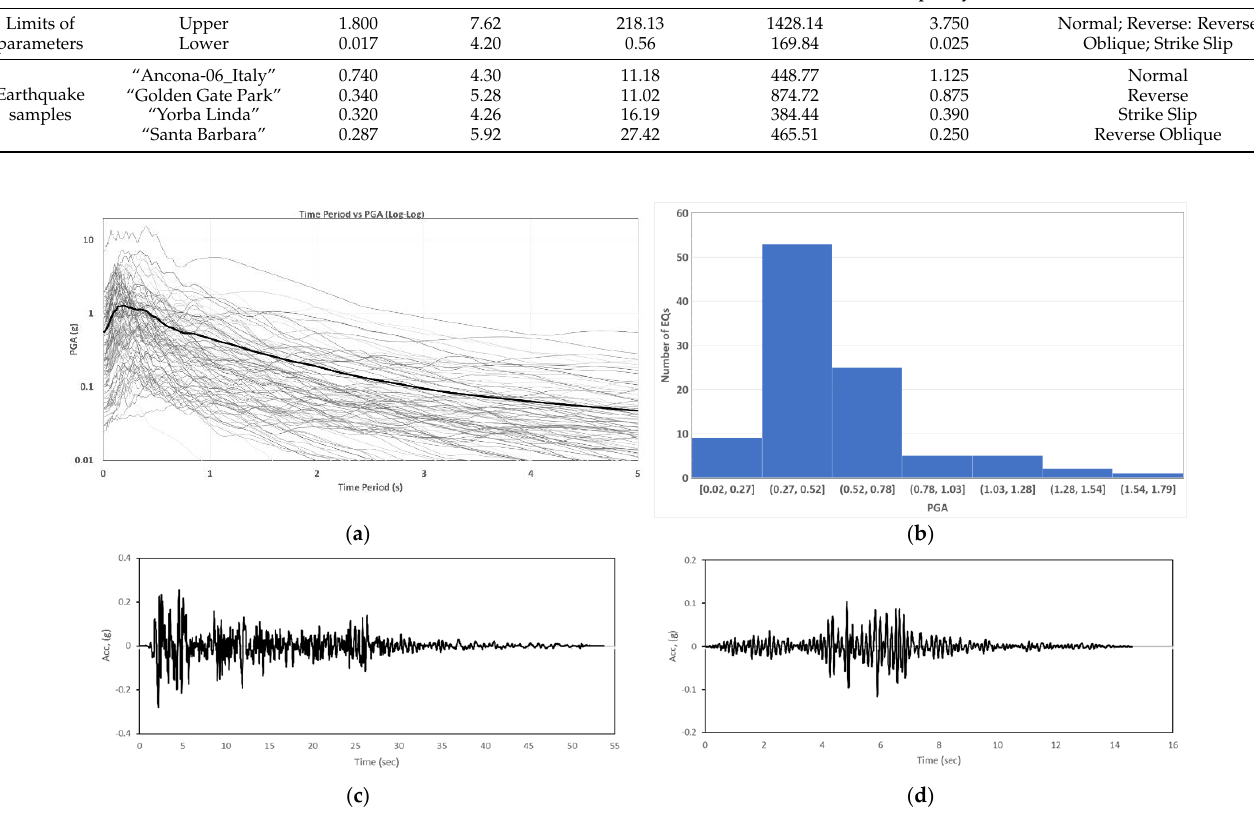
Figure 3. The earthquakes considered as input. ( a ) The response spectra of 100 input earthquakes. ( b ) The histogram of PGA ranges of the EQs. ( c ) The time history of Imperial Valley EQ. ( d ) The time history of Northern California